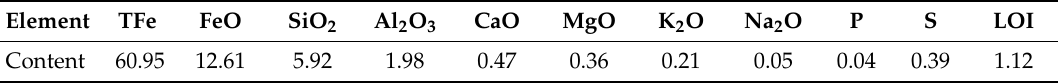
Table 1. Chemical composition of pyrite cinder (mass/%). TFe: Total Fe; LOI: Loss of ignition. Element